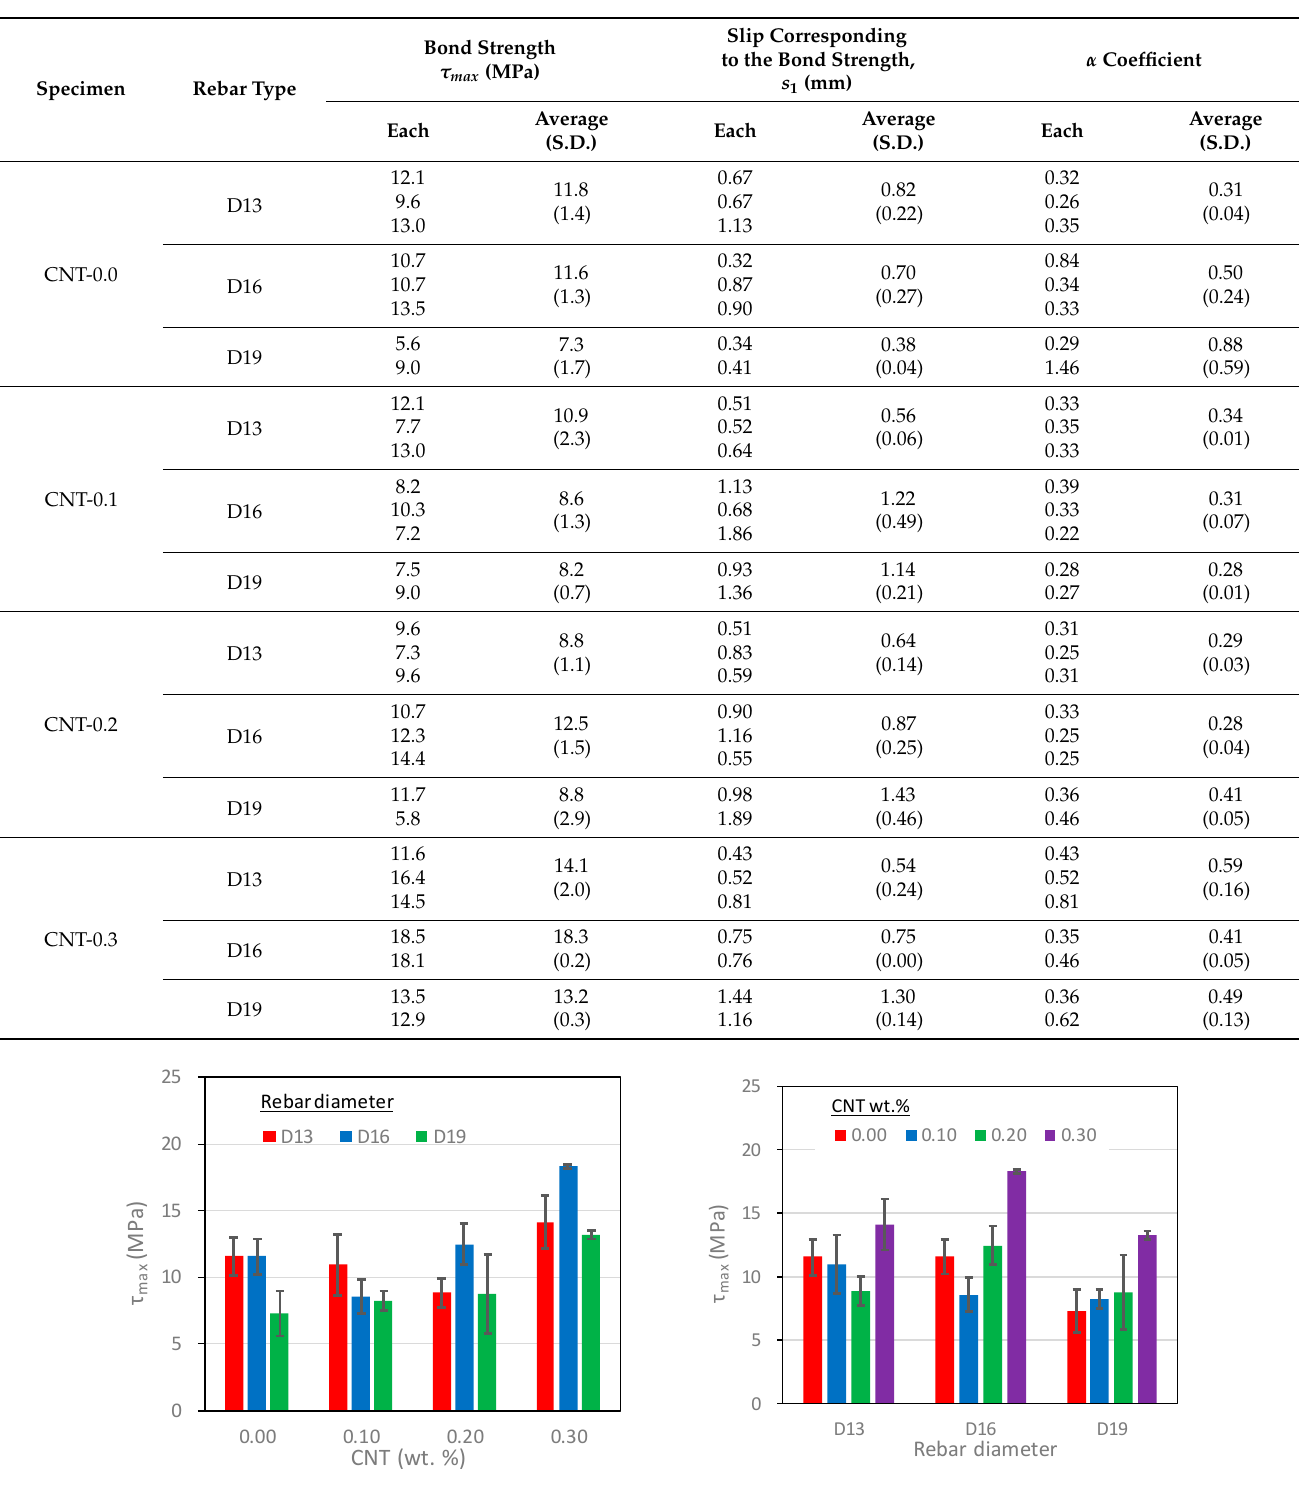
Table 7. Summary of the pullout test results.